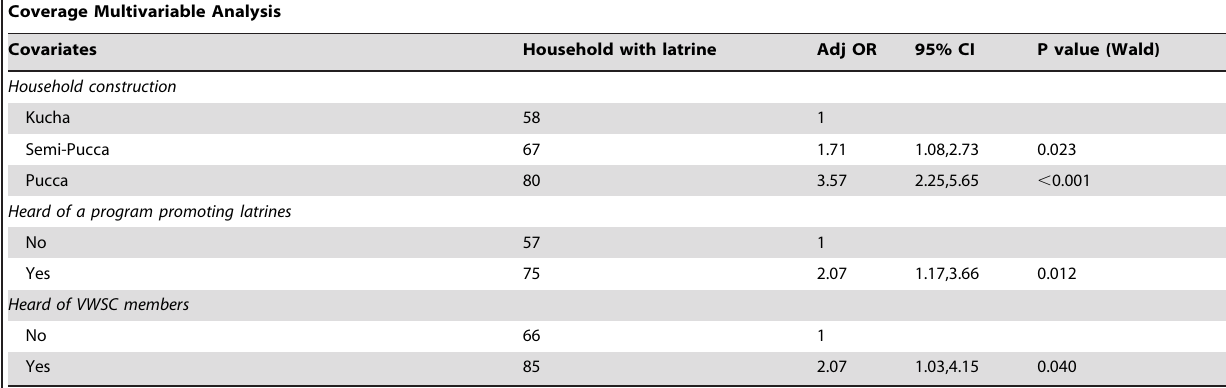
Table 3. Multivariable regression analysis of factors associated with latrine coverage.